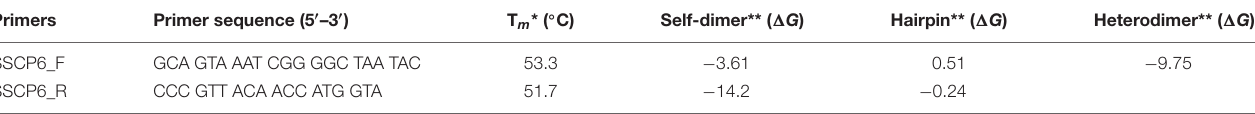
FIGURE 1 | SSU rRNA gene sequence conservation and positions of the single-strand conformation polymorphism (SSCP) primers. The line chart on the top and bottom panels illustrates the similarity level in percentage (red line) and Shannon’s entropy score (blue line) of each position on the multiple sequence alignment of the SSU rDNA gene. The lower panels represent the regions where the forward (SSCP6_F) and reverse (SSCP6_R) primers bind to the SSU rDNA gene. The gray arrows represent the direction of the primers. TABLE 1 | The SSCP primers used in this